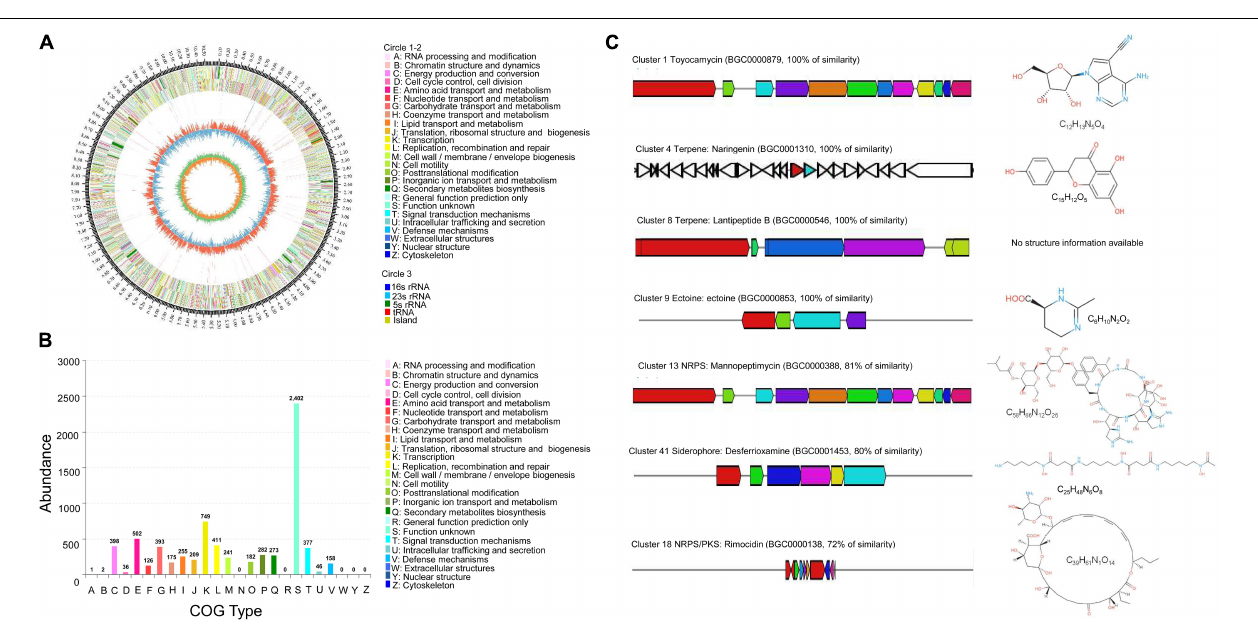
FIGURE 8 | Genome information and function annotation of Streptomyces BITDG-11. (A) Circular map of Streptomyces BITDG-11 genome. From outside to center, ring 1 is the mark of genome size. Rings 2 and 3 represent CDS on the forward/reverse strand. Different colors indicate the functional category of different COGs of CDS. Ring 4 is tRNA and rRNA. Ring 5 shows the G + C content. The outward red part indicates that the GC content of this region is higher than the average GC content of the whole genome. The inward blue part indicates that the GC content of this region is lower than the average GC content of the whole genome, followed by a G + C skew in ring 6. (B) COG annotation of Streptomyces BITDG-11 genome. (C) Biosynthesis gene clusters demonstrating more than 70% similarity with the known